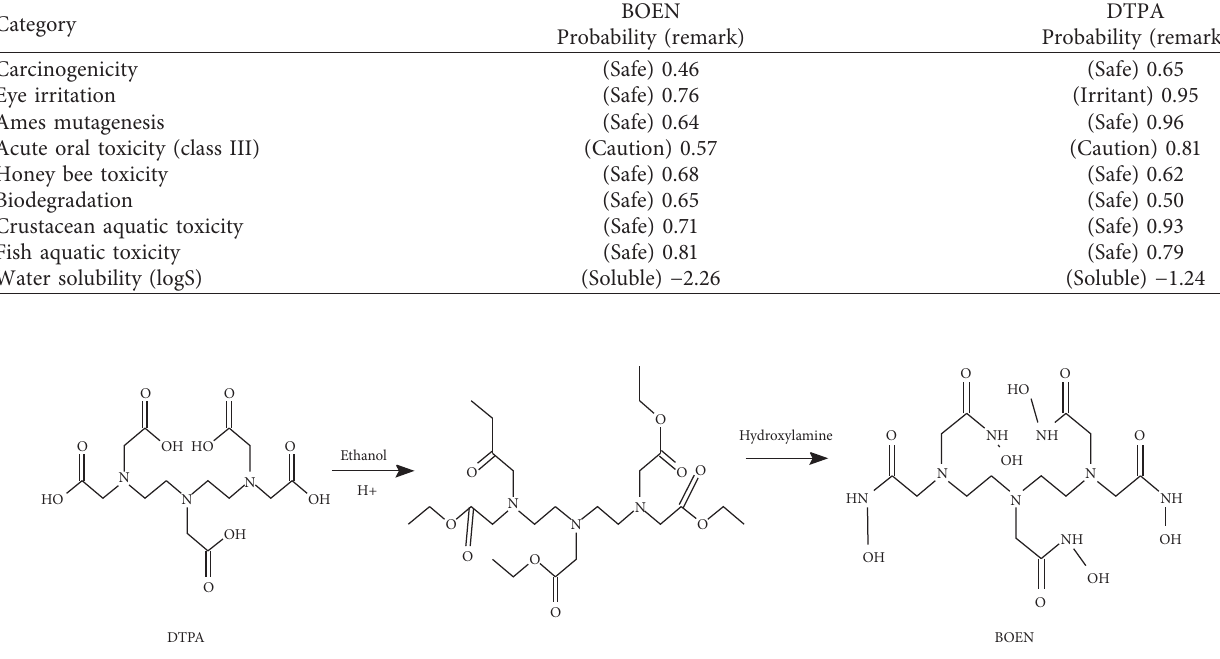
Figure 8: Proposed reaction scheme of BOEN synthesis from